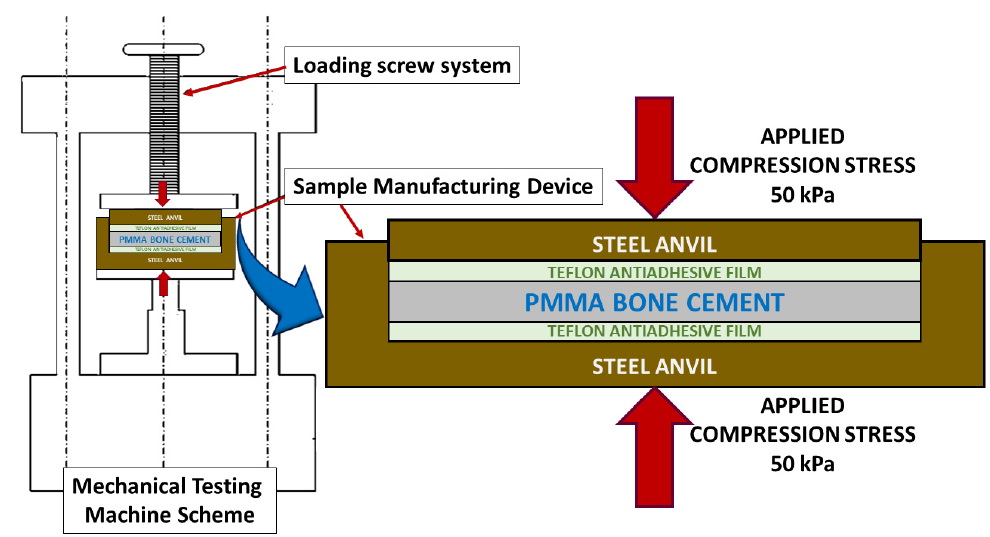
Figure 1. Simplified transversal section of the device developed for controlled fabrication of the bone cement. On the right, enlarged, it can be seen in greater detail transversal section detail of the sample manufacturing device.